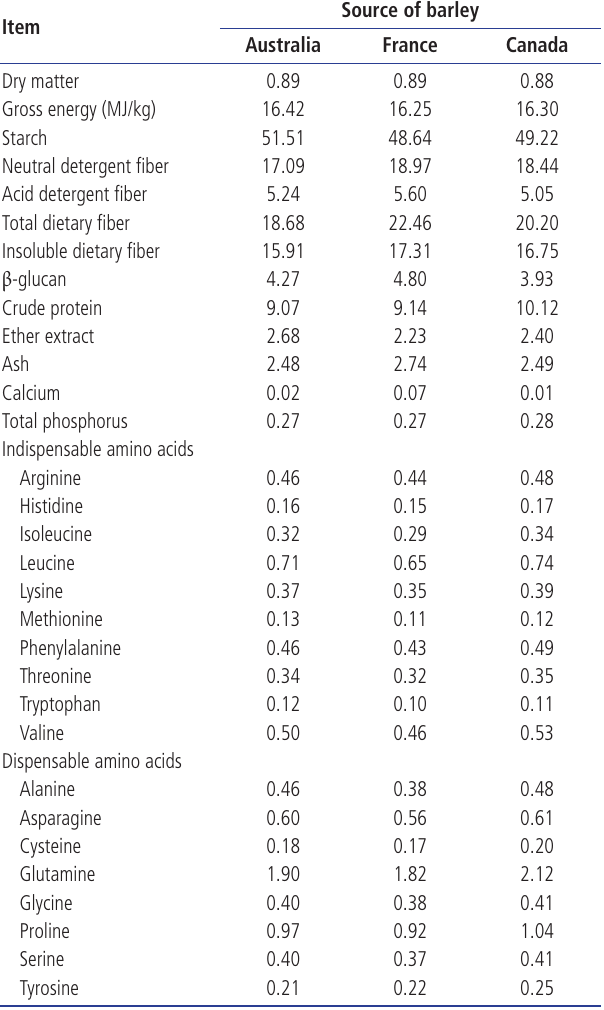
Table 1. Analyzed chemical and amino acids composition of barleys used in the experiment (% as-fed basis) 1)